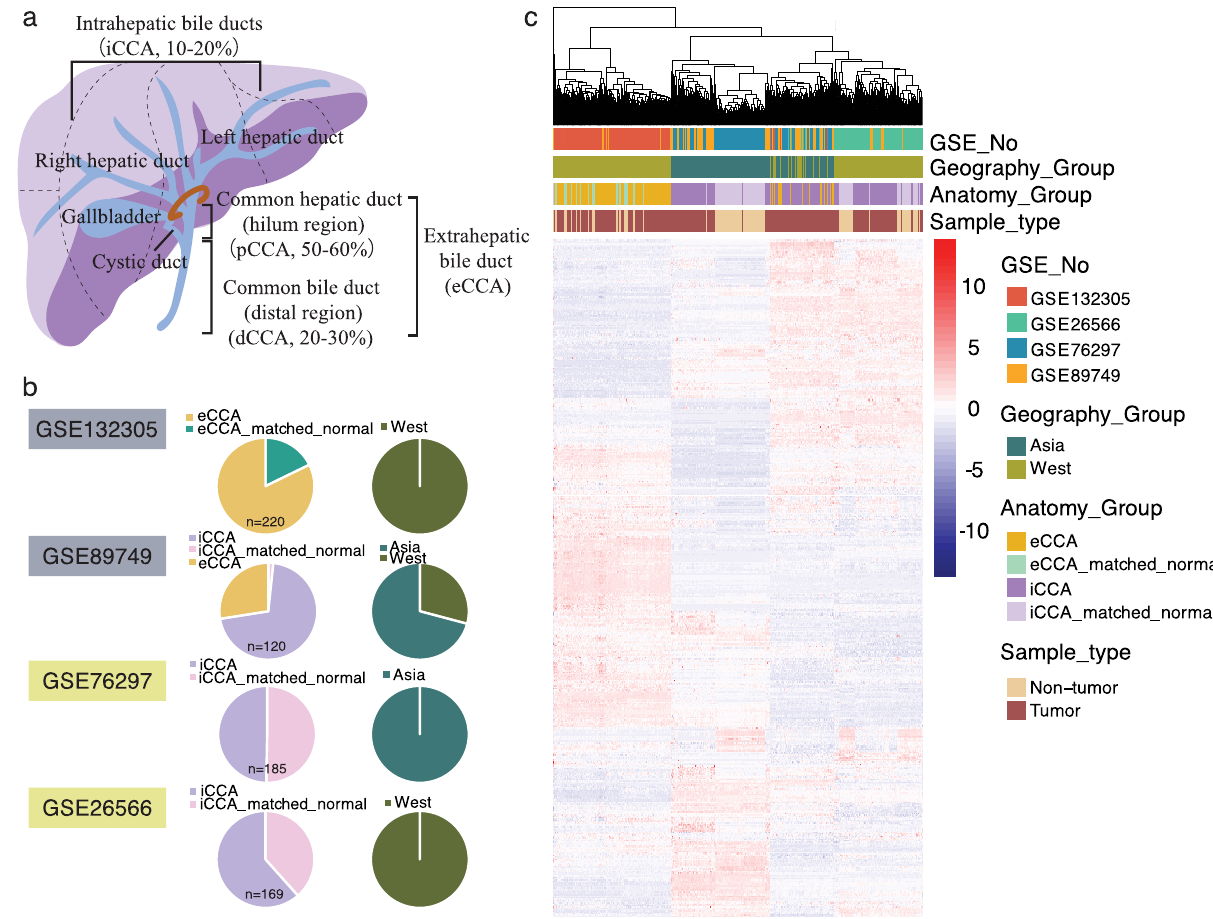
Figure 1. An overview of all datasets used in the current study and clustering. ( a ) An overview of the biliary tree and three subtypes of CCA according to anatomical location. ( b ) Illustration of the four GEO databases. ( c ) A heatmap clustering based on 3000 genes randomly chosen by the software. Rows represent genes, and columns represent